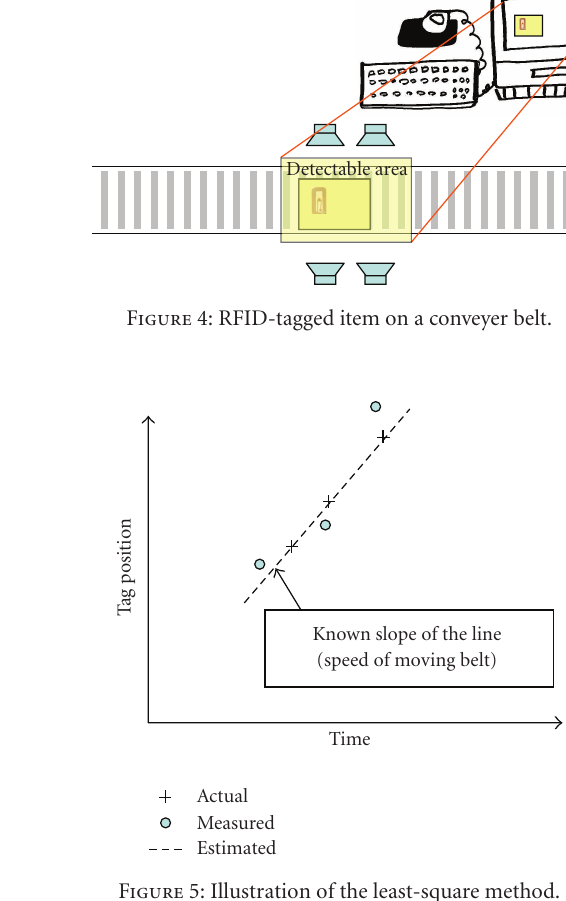
Figure 5: Illustration of the least-square